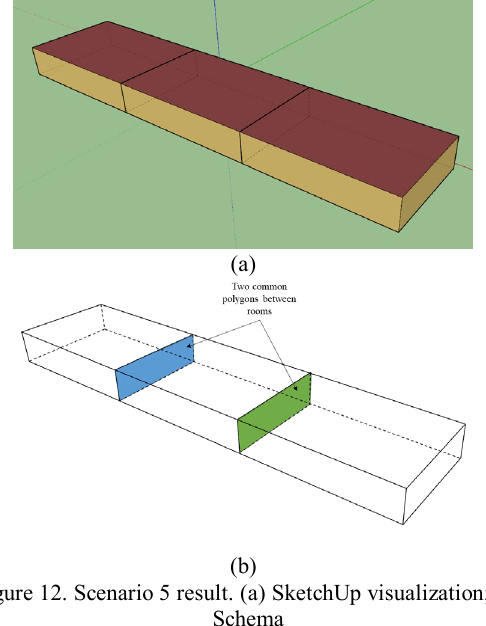
Figure 12. Scenario 5 result. (a) SketchUp visualization; (b) Schema